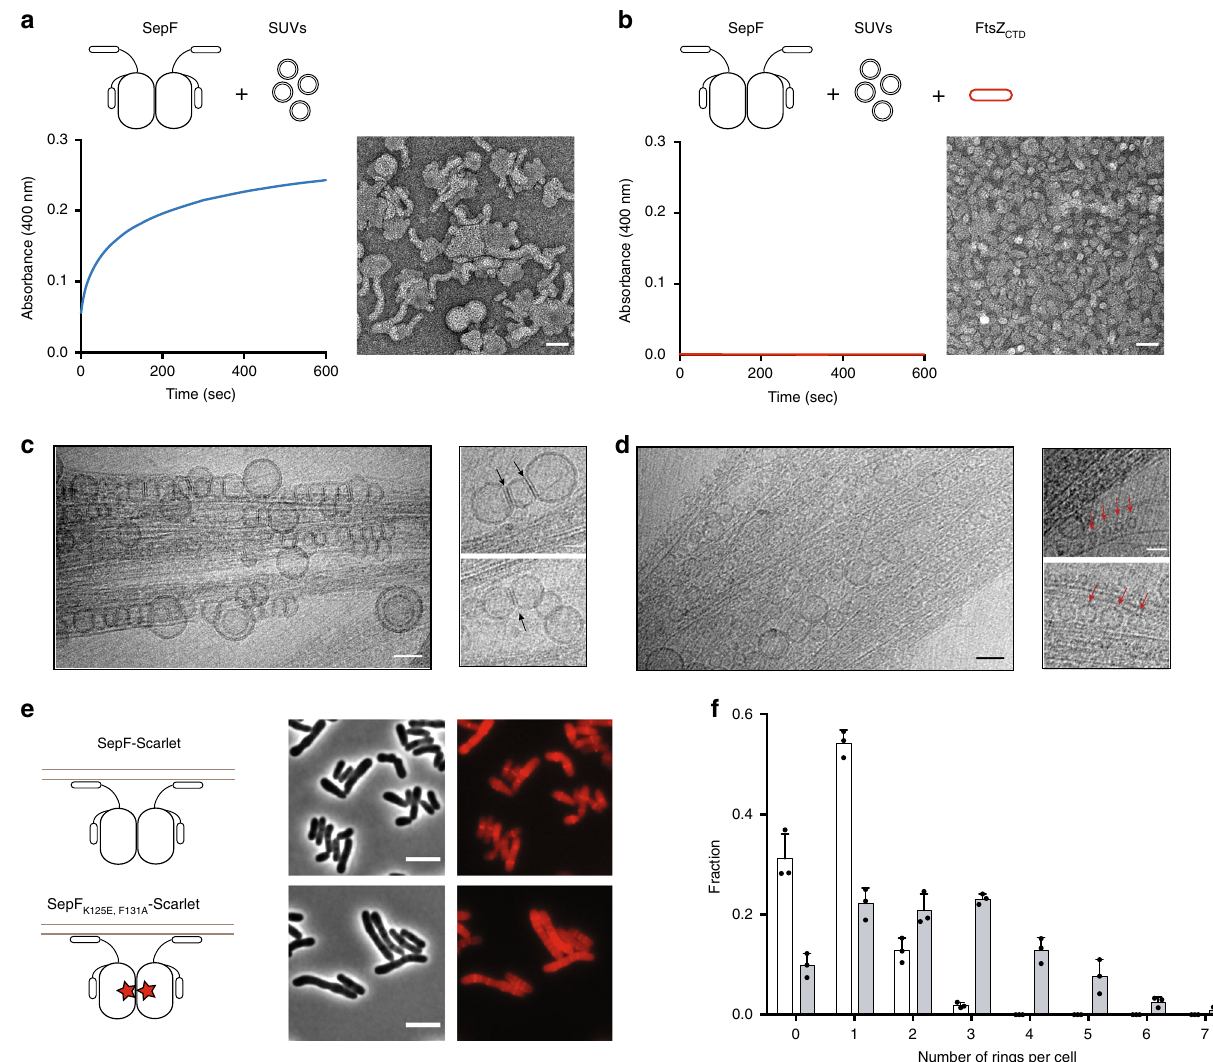
Fig. 5 SepF oligomerization upon lipid membrane-binding and reversal by FtsZ. a Polymerization assay and negatively stained EM images of the end- point of the assay for SepF in the presence of SUVs. Scale bar: 50 nm. b Idem for SepF in the presence of SUVs + FtsZ CTD . Scale bar: 50 nm. c Cryo-EM images of the ternary complex full-length FtsZ-GTP + SepF + SUVs. A bundle of FtsZ fi laments is decorated by tubulated lipid vesicles, mostly found on the periphery of the bundles. The smaller panels show two examples of tubulated lipid vesicles, where black arrows indicate the putative SepF rings. Scale bars in large and small panels, respectively: 50 and 30 nm. d In the central regions of the bundles, several small, non-tubulated, vesicles are in close contact with FtsZ fi laments. Red arrows indicate a few examples of these vesicles in the right panels. Scale bars in large and small panels, respectively: 50 and 30 nm. e Phase contrast (left columns) and Scarlet fl uorescent signal (right column) images show the phenotypic differences observed upon overexpression of SepF-Scarlet (top) and SepF K125E/F131A -Scarlet (bottom) in the WT strain, where endogenous SepF is present. Western blots of whole-cell extracts from the above strains as well as triplicate analyses for the distribution of cell length are shown in Supplementary Fig. 19. Scale bars = 5 μ m. f Frequency histogram indicating the number of ring-like structures per cell for SepF-Scarlet (white) and SepF K125A/F131A -Scarlet (gray). The frequencies were calculated from n cells imaged from three independent experiments for each strain (For SepF-Scarlet, n = 423, 471, and 477; and for SepF K125A/F131A -Scarlet, n = 336, 353, and 392). The bars, with data points overlapping, represent the mean ± SD. Source data are provided as a Source Data fi le. All data shown are representative of experiments made independently in